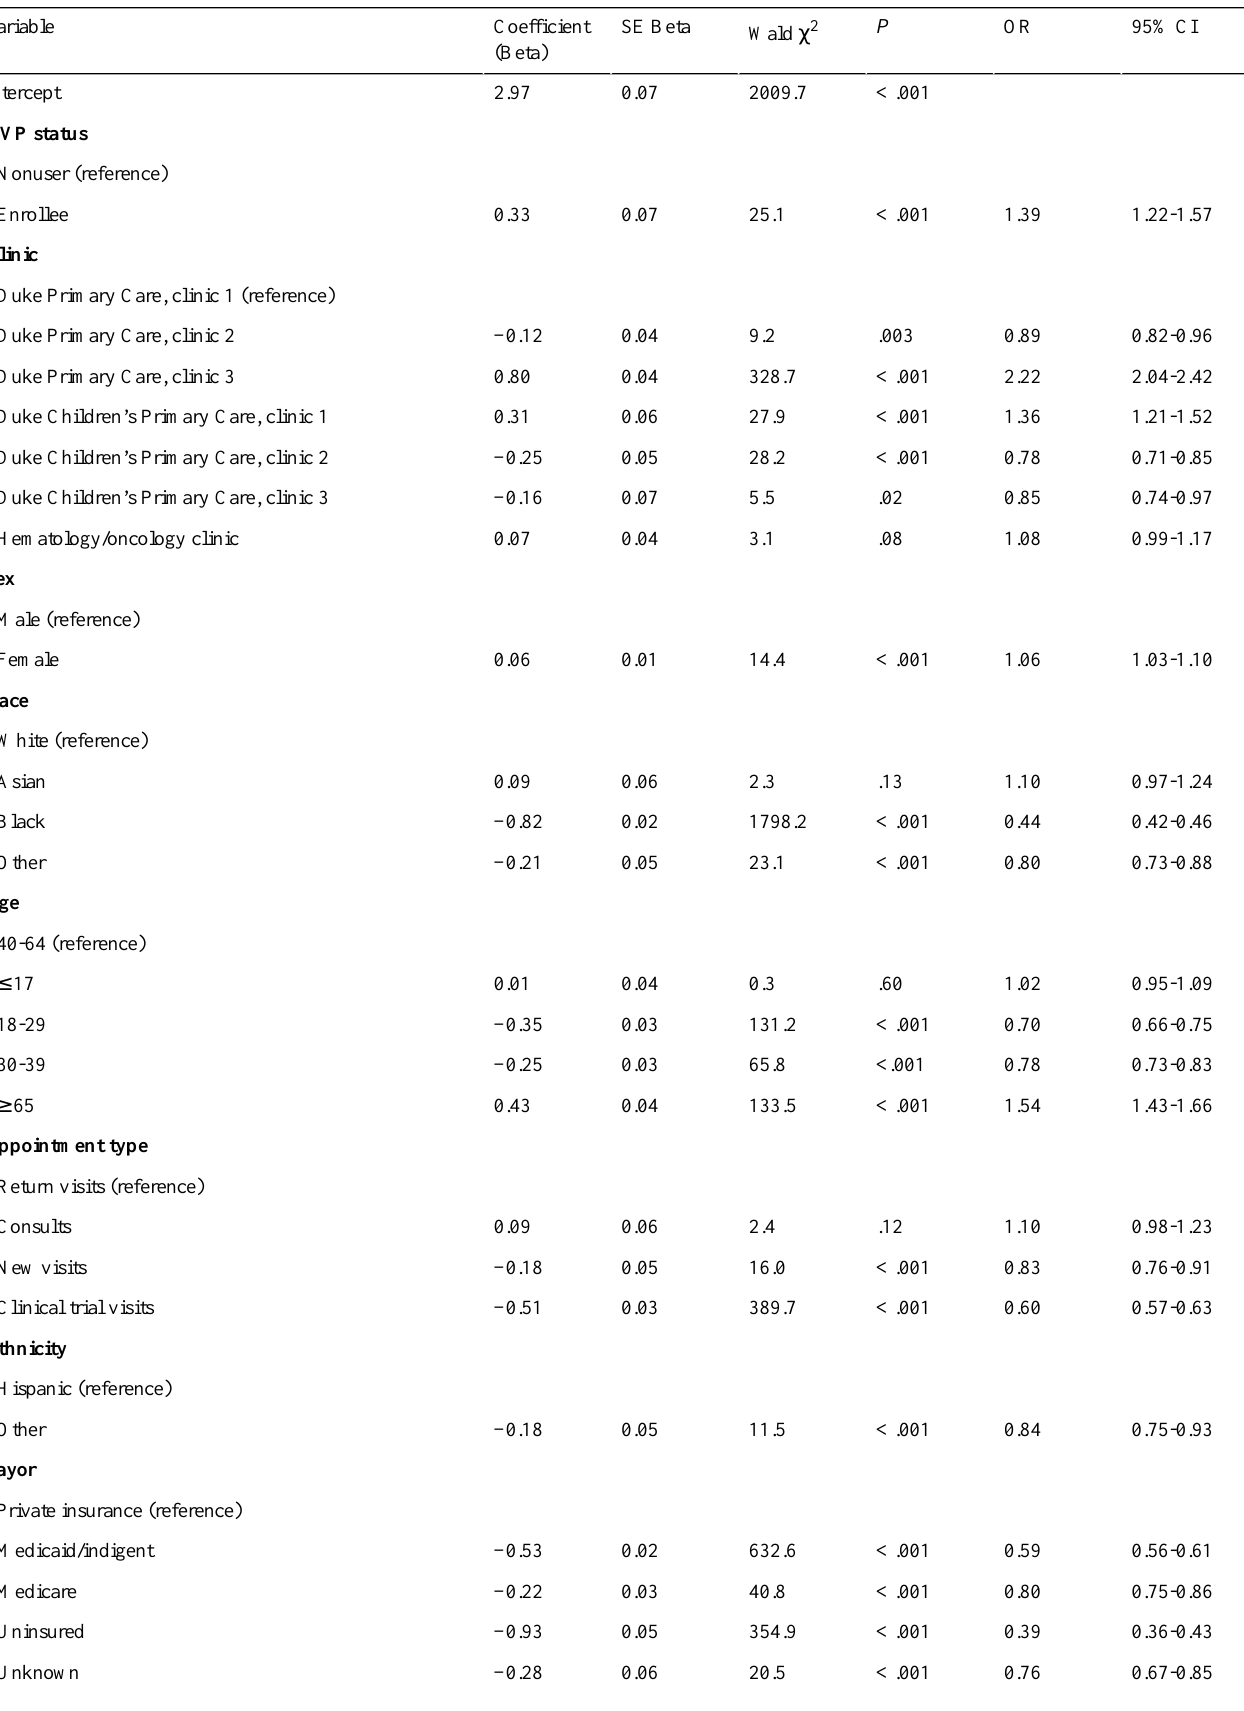
Table 3. Multivariable logistic regression model for the outcome of arrived